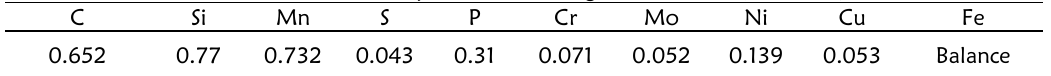
Table 1: Chemical composition of the high carbon steel (AISI 1065).